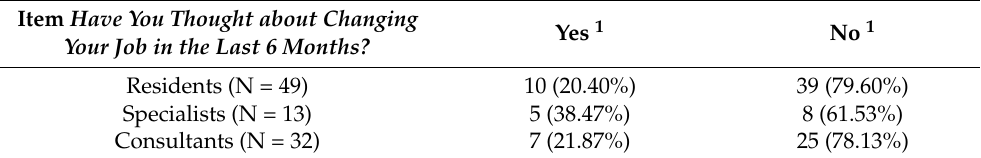
Table 3. Distribution of answer regarding changing job, considering the level of